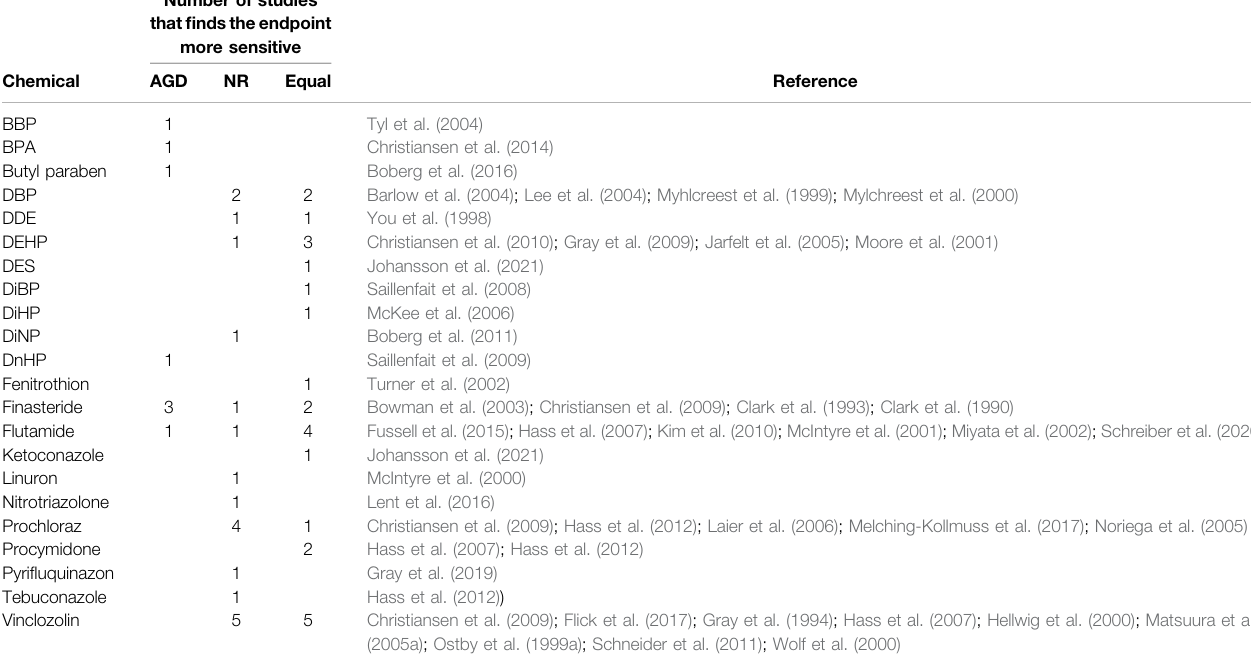
TABLE 2 | NR and AGD as the critical endocrine mediated effect. Number of studies that fi ndstheendpoint